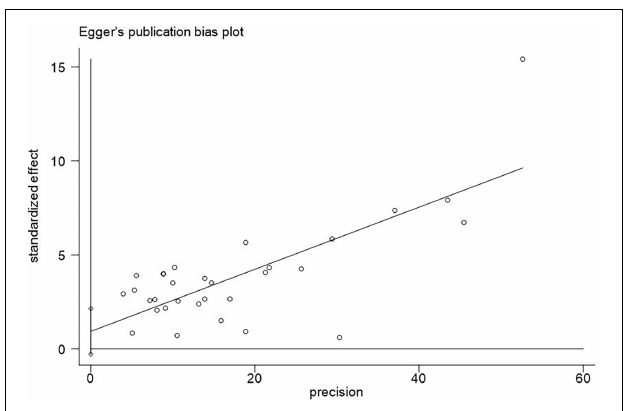
FIGURE 2 | Egger’s test for publication bias of 31 included articles for adverse cardiovascular outcomes ( P = 0.125).